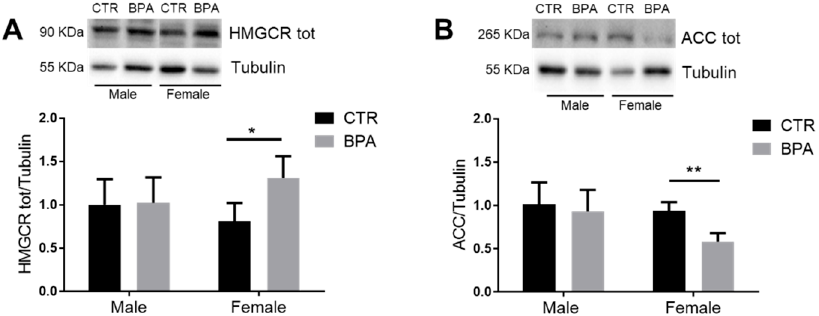
Figure 3. Effects of prenatal exposition to 2.5 µ g/kg/day of BPA on HMGCR and ACC total levels in fetal livers of male and female rats. Typical Western blot and densitometric analysis of total HMGCR ( A ) and total ACC ( B ) levels. Tubulin was used to normalize protein loading. Values are expressed as mean ± SD, n = 6 for each experimental group. Differences between groups were considered as significant at p < 0.05 and were analyzed with two-way ANOVA, followed by Tukey post hoc test. * p < 0.05; ** p < 0.01 vs. CTR female.